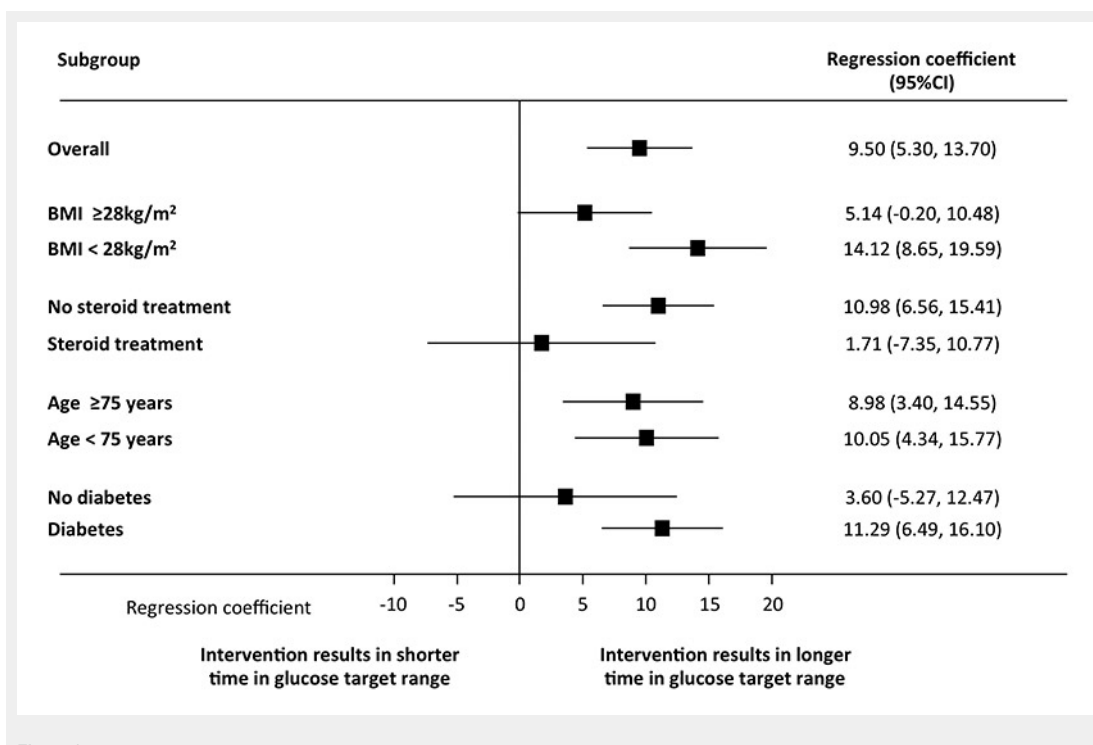
Figure 3 Effect of the intervention on time in glucose target range (5.5–7.0 mmol/l) overall and in subgroups. All models of multivariate analyses were adjusted for age, gender, body mass index (BMI), glucocorticoid use and previously known diabetes. CI = confidence interval.